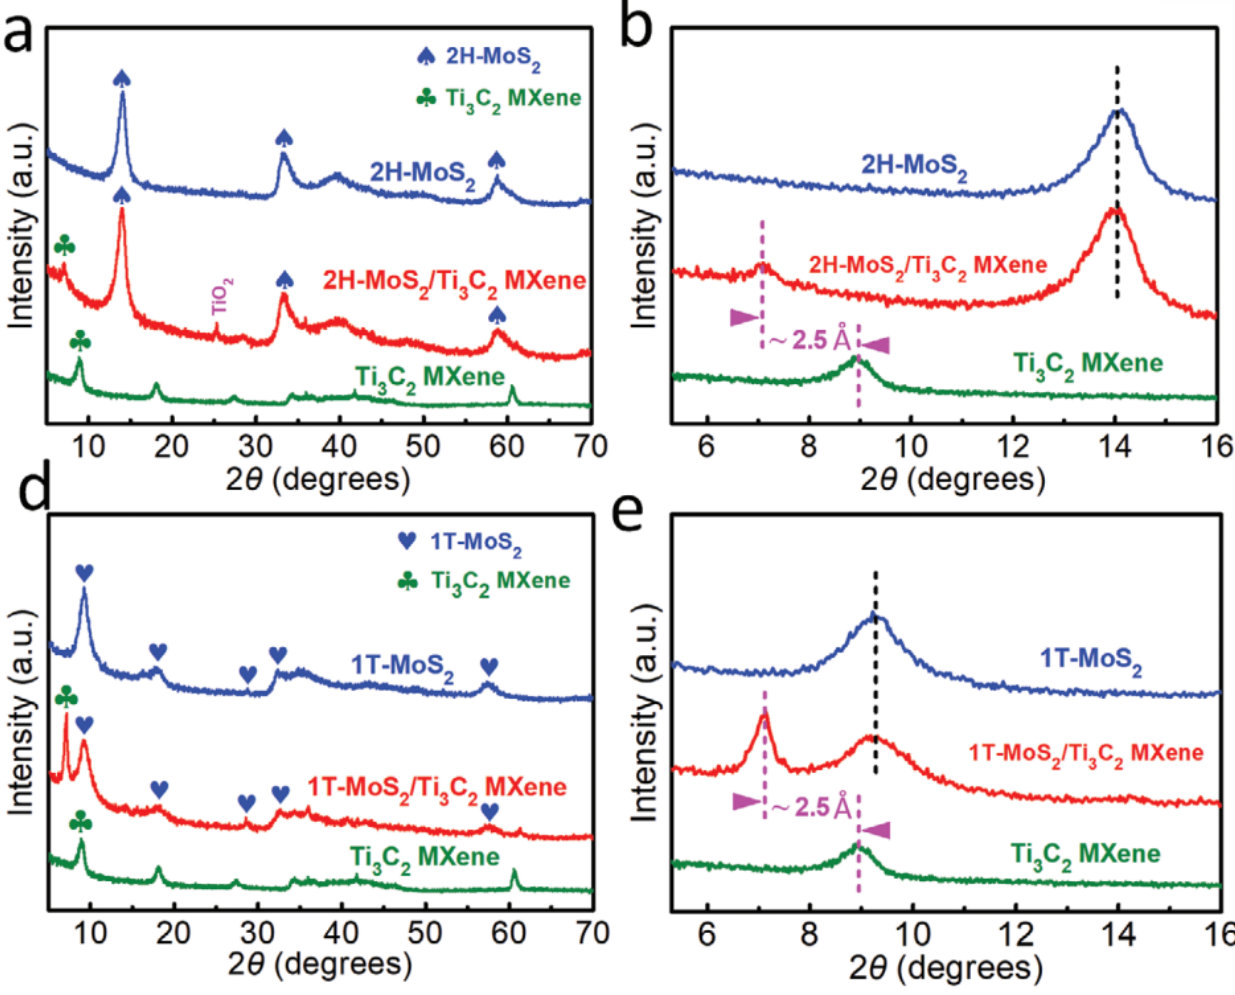
Figure 16. The crystal structure of samples. ( a ) XRD patterns of the 2H-MoS 2 , the Ti 3 C 2 MXene, and the 2H-MoS 2 /Ti 3 C 2 MXene heterostructure, ( b ) The magnification of XRD patterns in ( a ), ( d ) XRD patterns of the 1T-MoS 2 , the Ti 3 C 2 MXene, and the 1T-MoS 2 /Ti 3 C 2 MXene heterostructure, ( e ) The magnification of XRD patterns in ( d ).Reproduced with permission from [87]. Copyright 2019 Wiley.